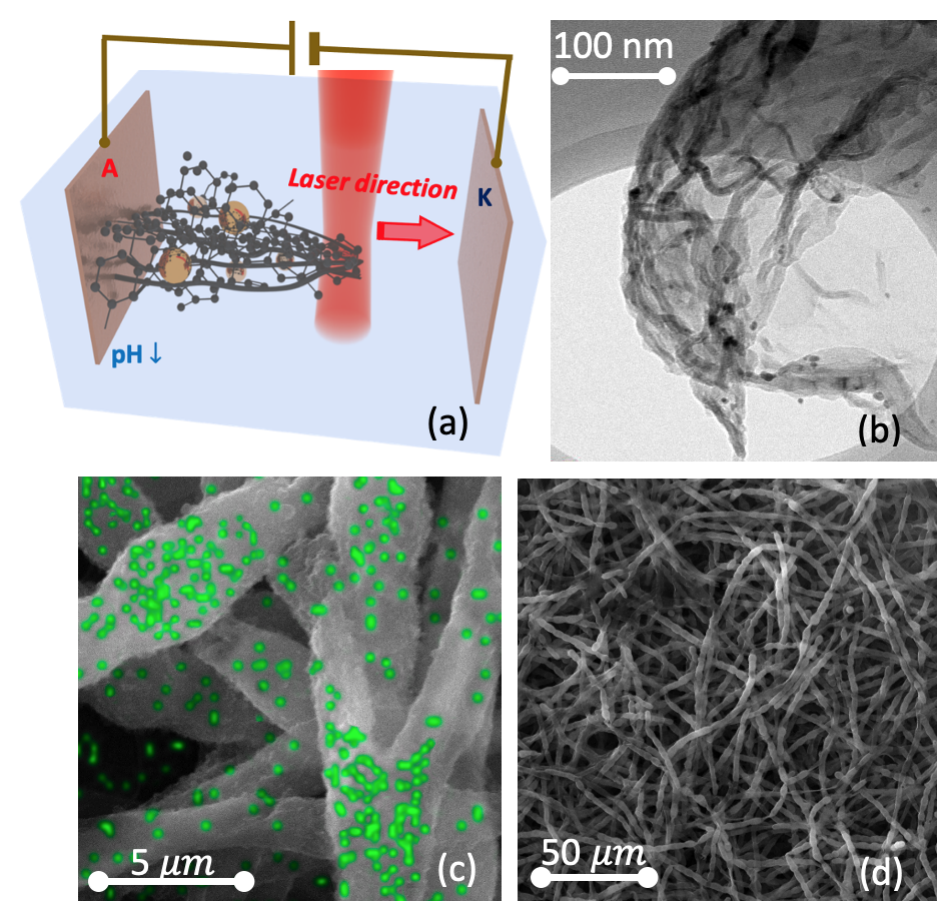
Figure 1. The top panel ( a ) illustrates the concept of self-assembly of sponge-like structures based on sp 2 carbon doped with a high concentration of sp-carbon bonds. The carbon system is injected by auxiliary charges due the vicinity of endcapped Au NPs (shown as yellow spheres). Near the anti-cathode the pH-factor of the DI colloidal system falls down giving start to the sponge assembly. The elementary part of a peeled sponge has been discovered by the high resolution transmission electron microscopy (HR TEM) on ( b ), where dark points correspond to the Au NPs. The full picture at a macroscale is shown in panels ( c , d ). These images reveal the bunch arrangement composing the sponge body of at least few mm in its size. The panel ( c ) combines the scanning electron microscopy (SEM) image and with the results of EDAX element analysis in order to make the Au NPs accumulation visible (gold distribution marked by green spots). One can see gold nanoparticles (Au NPs) accumulated in the centers of each bunch segments and splitters. This shows the role of NPs as growth points for the carbon